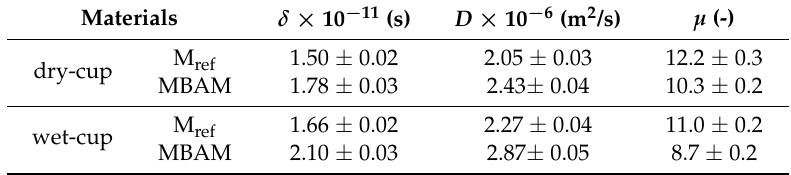
Table 8. Water vapor transmission